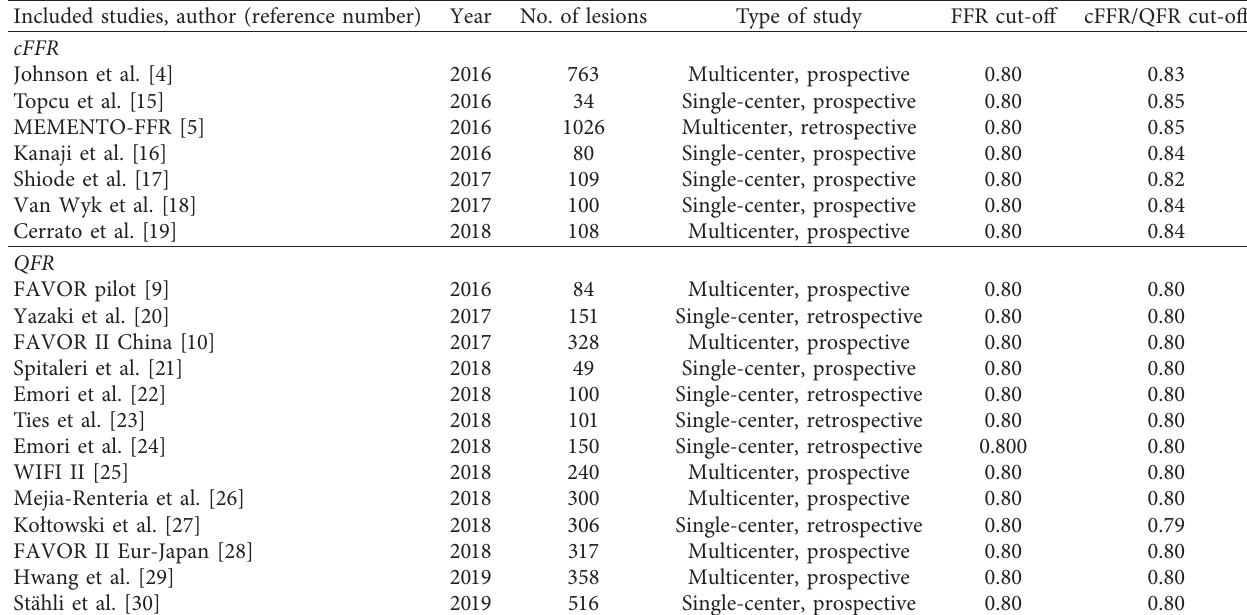
Figure 1: Flow-diagram of search and selection strategy. Table 1: Study